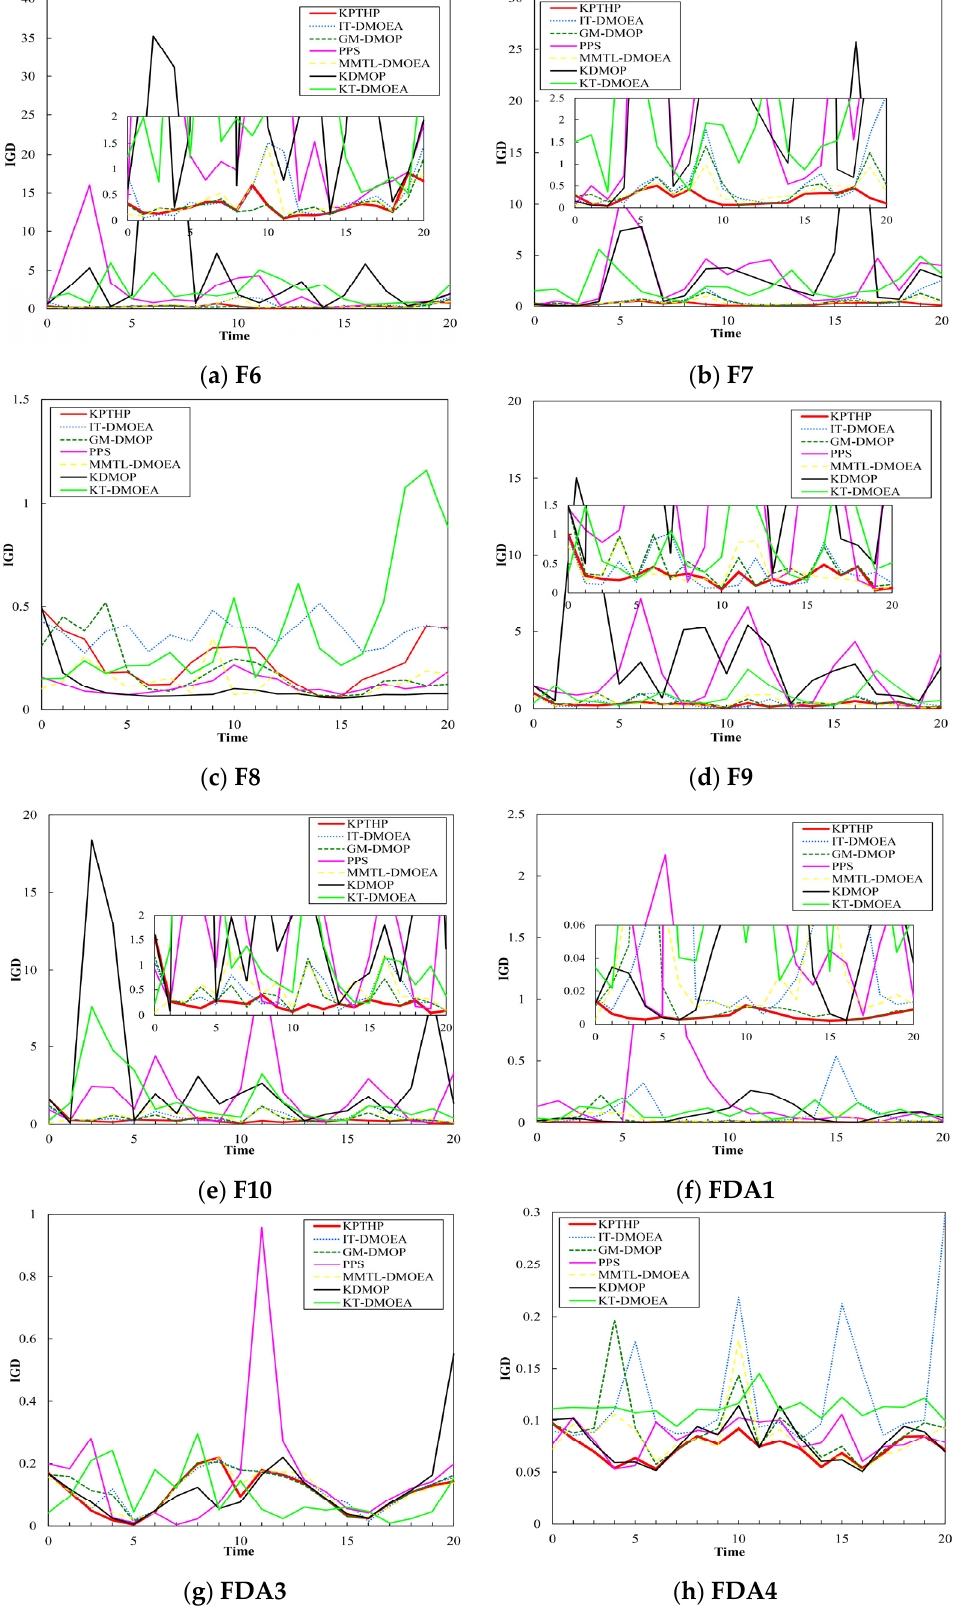
Figure 6. Evolutionary curves of IGD values for eight algorithms with n t = 5 and τ t = 10 on F6-FDA4.